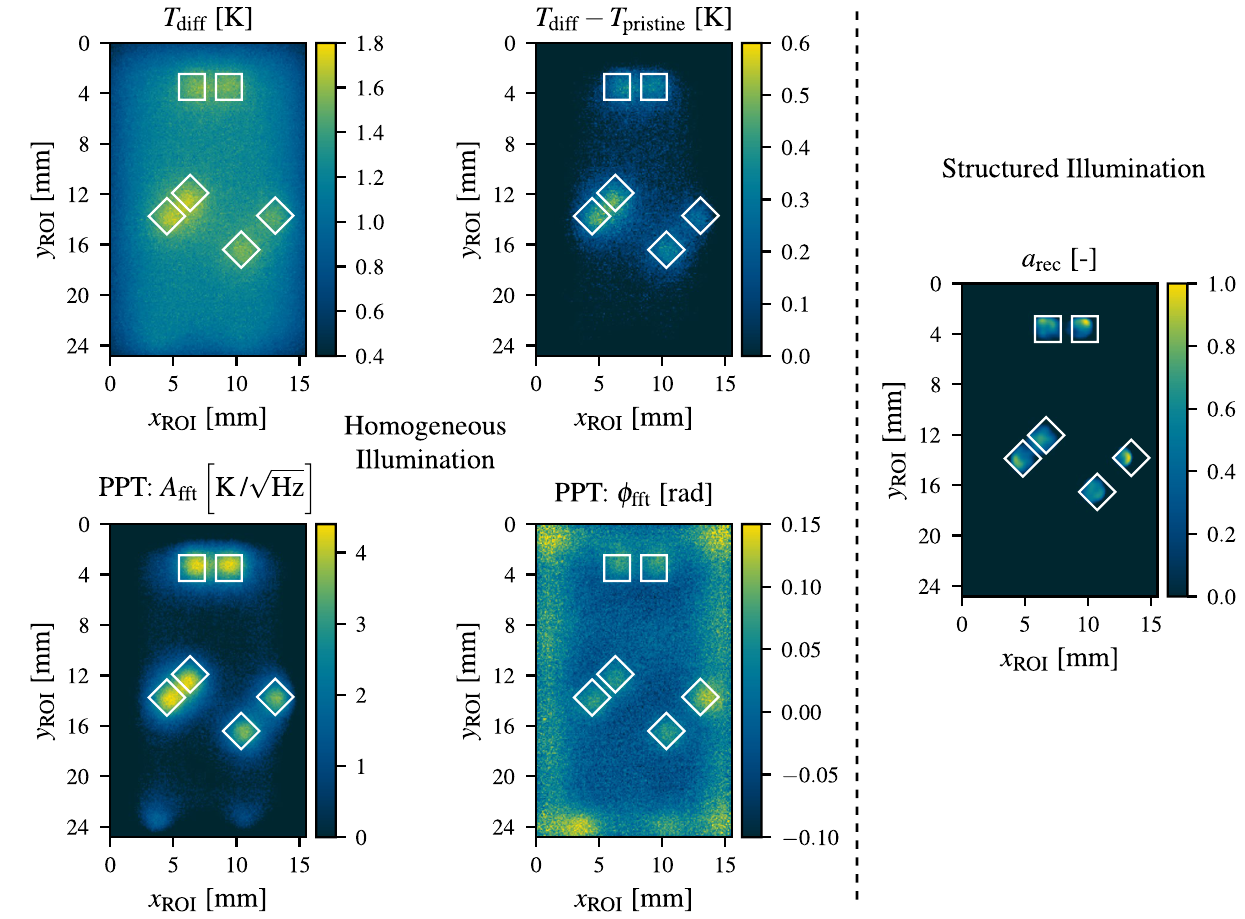
Figure 8. Qualitative comparison of different defect detection methods: The left four plots show results obtained using conventional detection methods with homogeneous illumination. The top left plot contains the temperature increase T diff obtained at t eval = t pulse = 0.5 s . The top right plot shows a difference thermogram where from each pixel the expected increase in temperature for a pristine subarea of the ROI is subtracted. The bottom two plots display the amplitude and phase image for a pulsed phase thermography (PPT) evaluation on T diff for a frequency of f PPT = 0.516 Hz . On the right, the photothermal SR reconstruction result as obtained in Fig. 7 is depicted. The true defect positions are indicated by white